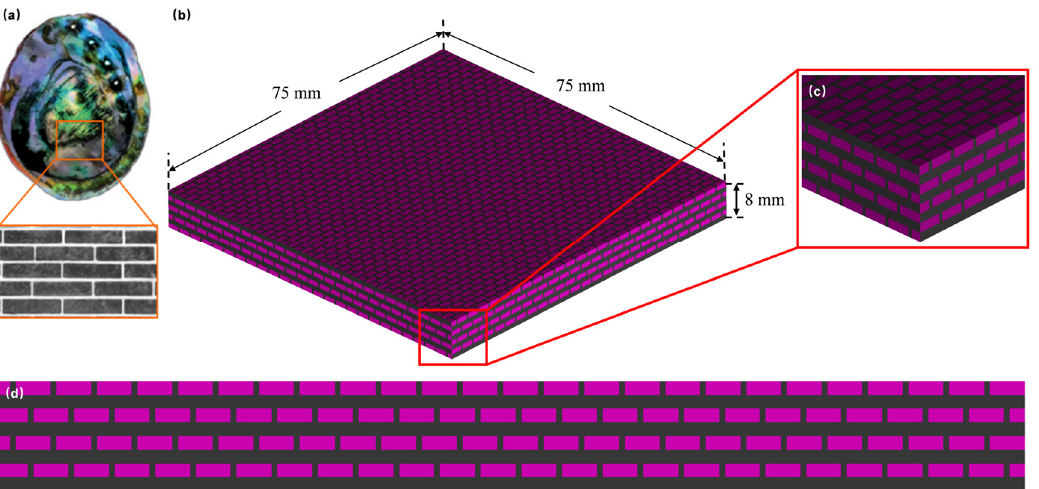
Figure 2. Schematic diagram of Bio-B inspired by beetle exoskeleton [34] ( a ) microstructure of beetle exoskeleton; ( b ) schematic diagram of Bio-B specimen model; ( c ) local feature of bio-B structure; ( d ) the side view of the Bio-B structure.